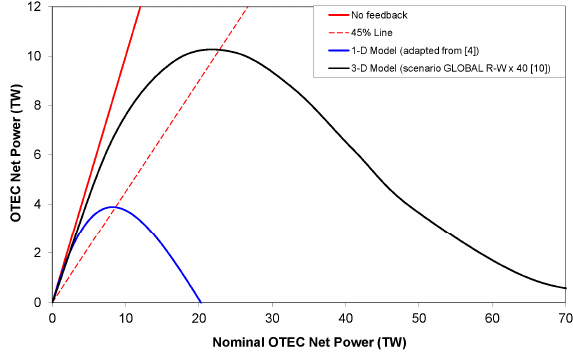
Figure 1. Overall OTEC net power as a function of nominal OTEC net power (i.e., with unchanging seawater temperatures) using two models of vastly different complexity; 1-D results have been adapted to inputs and conventions of the 3-D study.